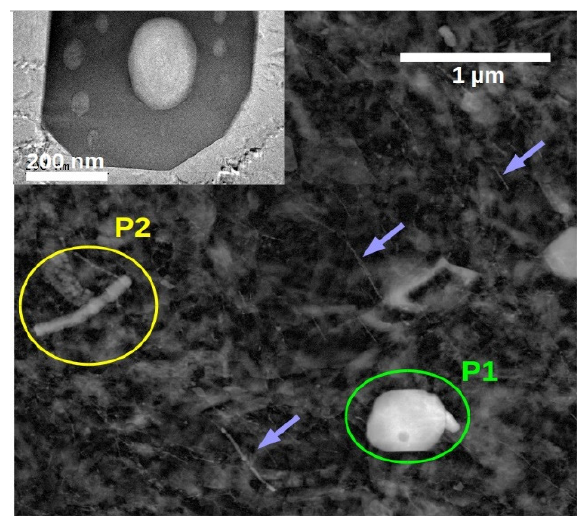
Figure 17. STEM image of Mg5Zn0.3Ca, HPT-processed at 0.5 rotations, showing P1, P2 and thinner precipitates (blue arrows). The TEM image in the top left corner is a close-up of the P1 precipitate. Thinner precipitates are located at the grain boundaries, following their contours.